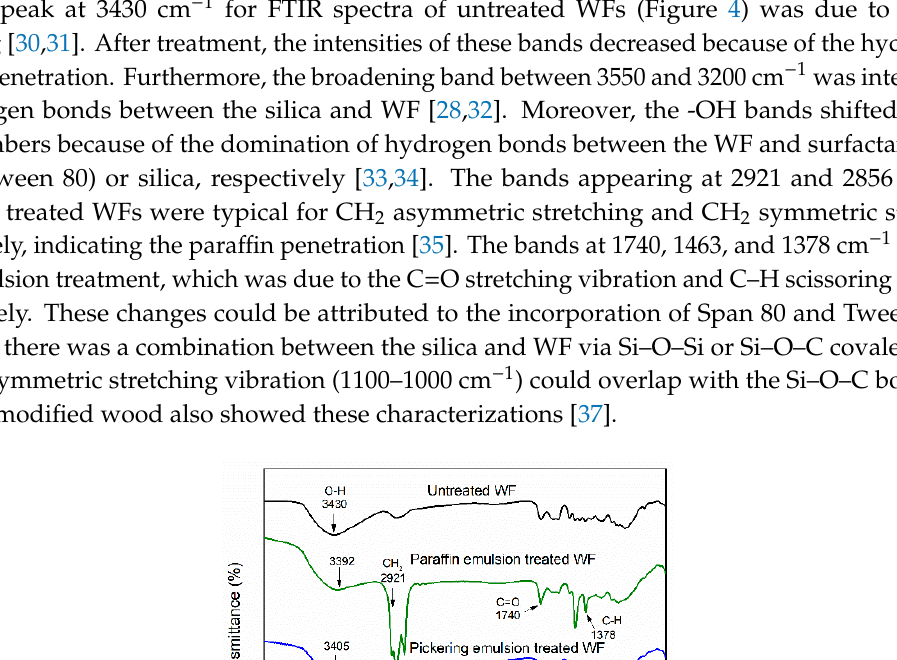
Figure 5. Moisture adsorption of untreated ( control) and emulsion treated WFs. 3.4. MFI Analysis Generally, the higher value of MFI makes polymers flow well around the fillers and it can improve fillers distribution in the polymer matrix, as a result, promoting the interfacial interaction